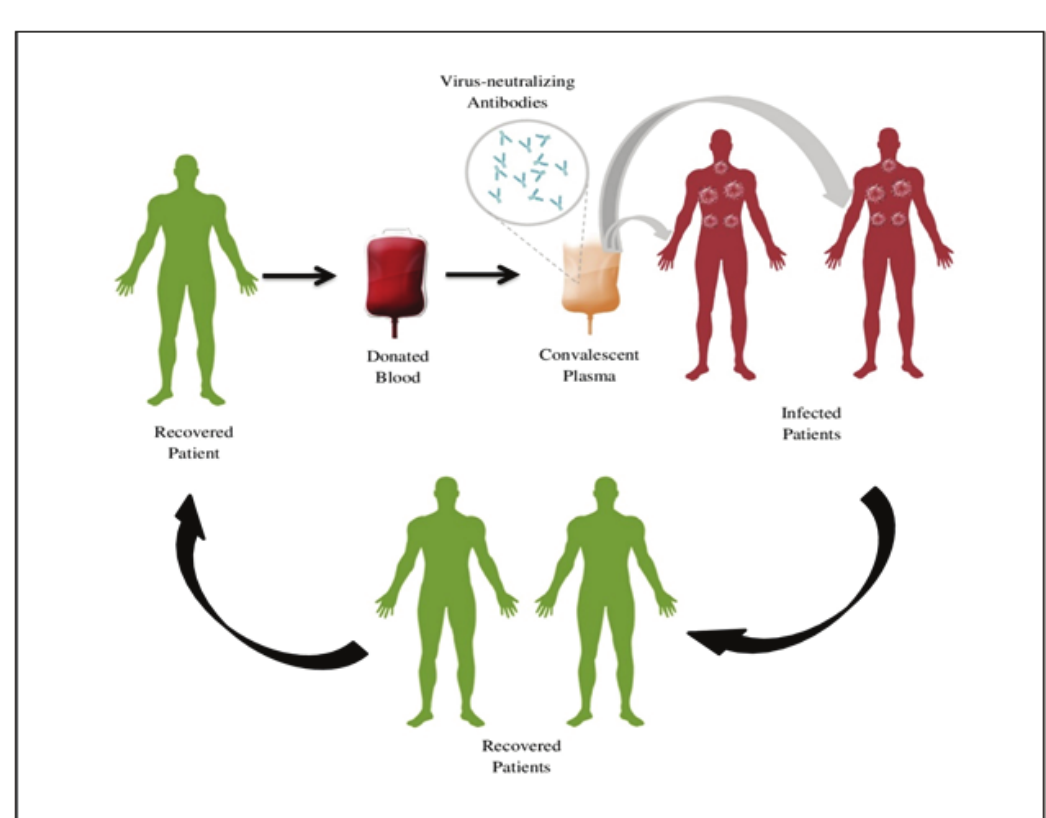
Figure 1: Mechanisms of convalescent plasma therapy (This image was created by author Mujahed I.